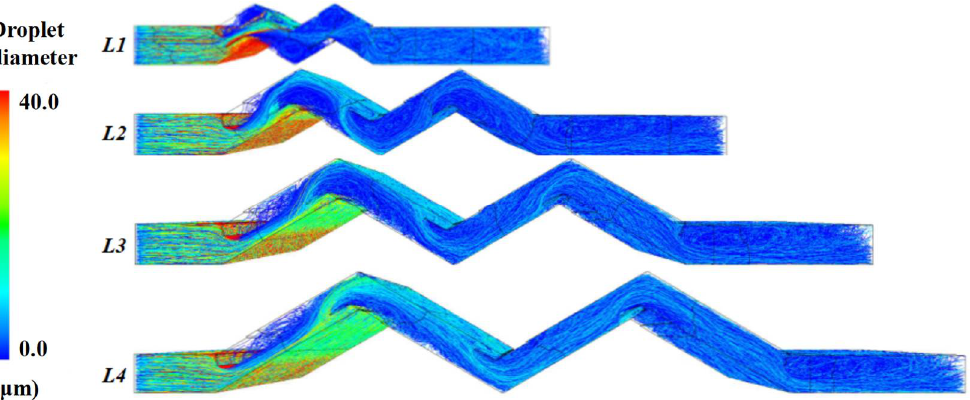
Figure 12. 3D droplet path line contour colored by droplet diameter under inlet velocity U g = 12.00 m/s in different wavelengths.